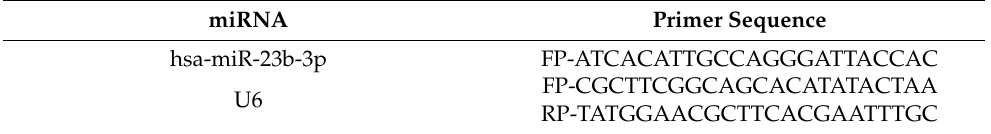
Table 2. Primer Sequences of microRNA. miRNA Primer